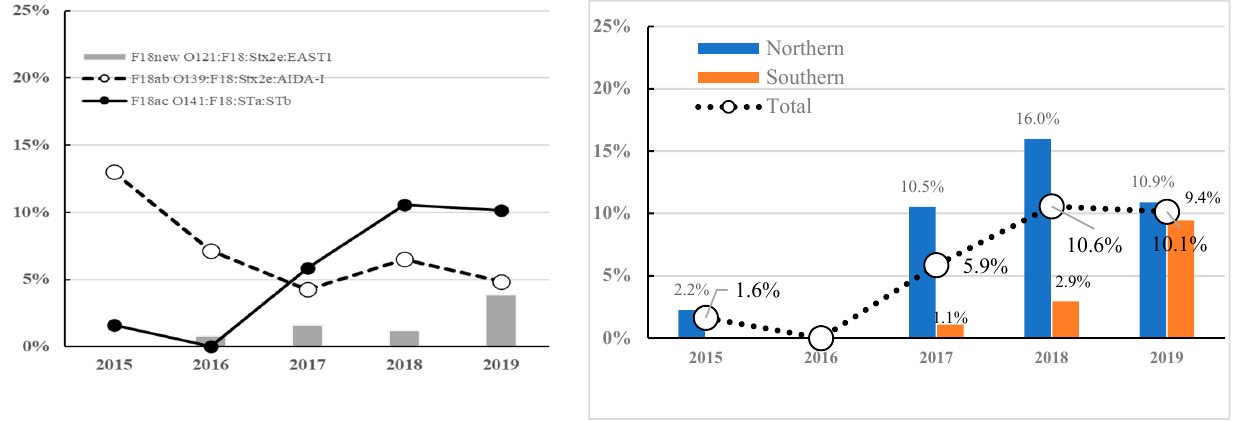
Figure 3. Change of F18 positive E. coli (O141:F18ac:STa:STb, O139: F18ab:Stx2e:AIDA-I and O121:F18new:Stx2e:EAST1) and regional frequency of dominant serovirotype (O141:F18ac:STa:STb) from 2015 to 2019.